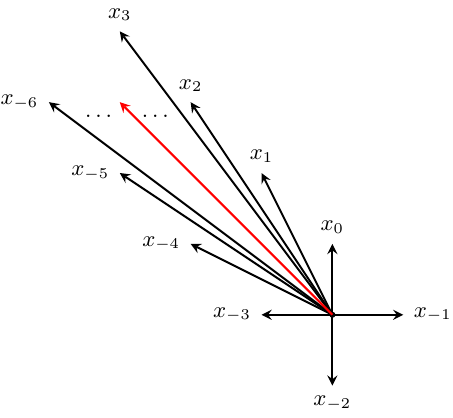
Figure 5. g -vector fan associated with the A 1 , 1 cluster algebra. There are an infinite number of cluster variables whose g -vectors approach a limiting ray, ~g g -vectors is provided in eq.